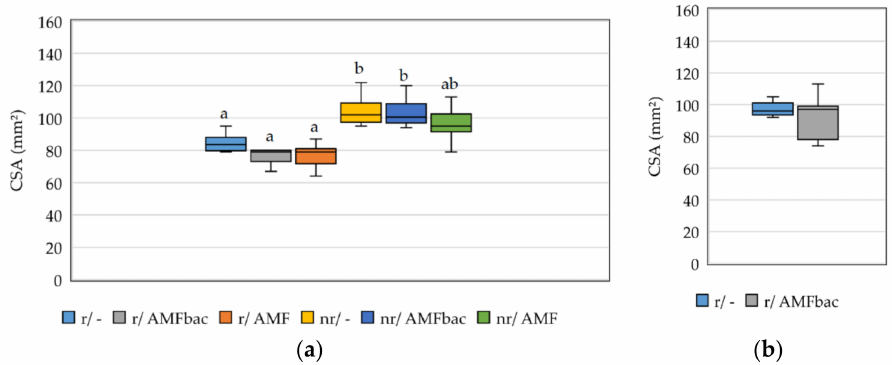
Figure 5. AMFbac Pot Experiment B-CSA (mm 2 ) apple understocks’ type ( a ) Marc and ( b )